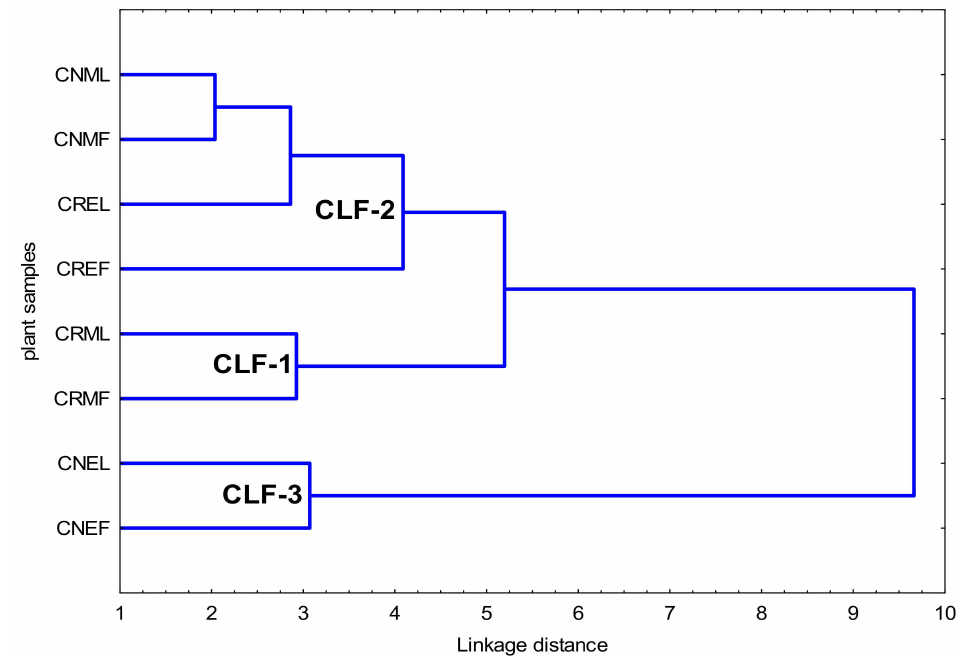
Figure 7. Hierarchical cluster analysis with all variables obtained for the Cotoneaster leaves and fruits using the Ward’s method and Euclidean squared distance. CNML—methanol–acetone–water (3:1:1,